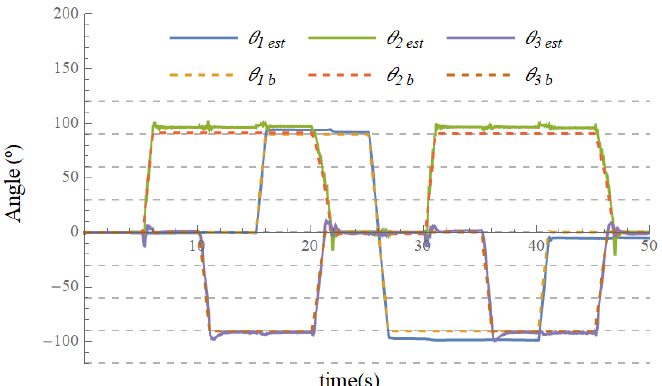
Figure 20. Evolution of estimates of the joints’ angles when testing the joint model using all